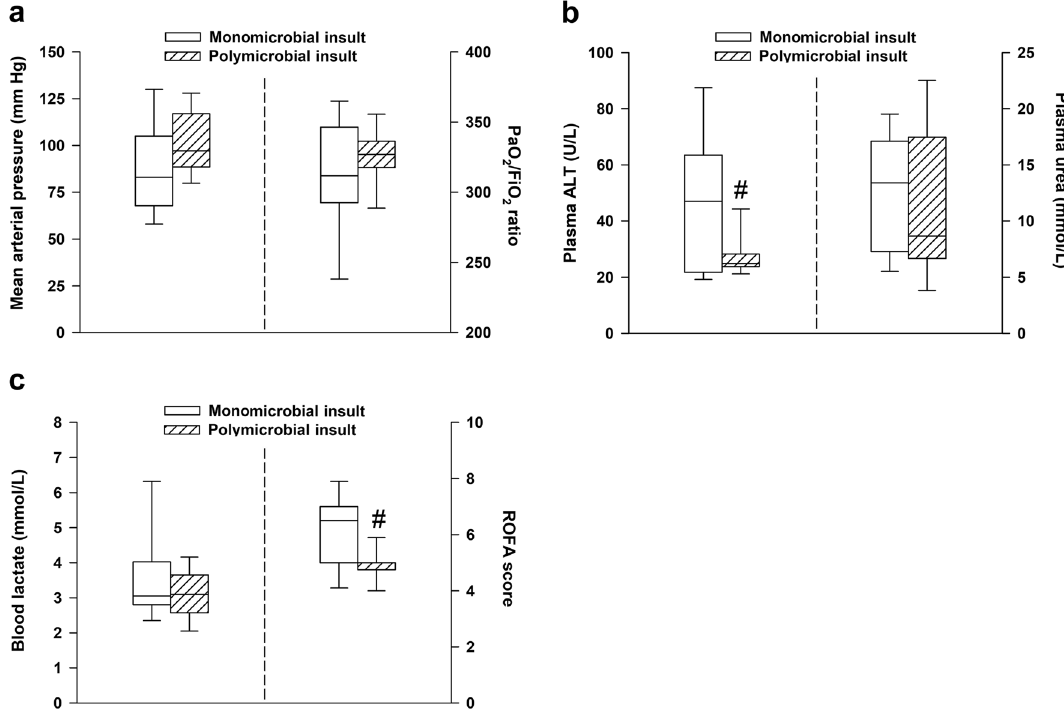
Figure 7. Comparison of rat-specific organ failure assessment (ROFA) parameters in E. coli monomicrobial (n = 10) or polymicrobial subgroups (n = 10) at 24 h. (a) Mean arterial pressure and lung injury (represented as the Carrico index), (b) plasma alanine aminotransferase (ALT) and plasma urea levels, (c) blood lactate levels and cumulative ROFA score. Plots demonstrate the median (horizontal line in the box) and the 25th (lower whisker) and 75th (upper whisker) percentiles. Between groups, comparison of ROFA score values was made with the Mann–Whitney U test, whereas ROFA components were compared with the Welch independent samples t-test. # P < 0.05 monomicrobial vs polymicrobial septic subgroups.